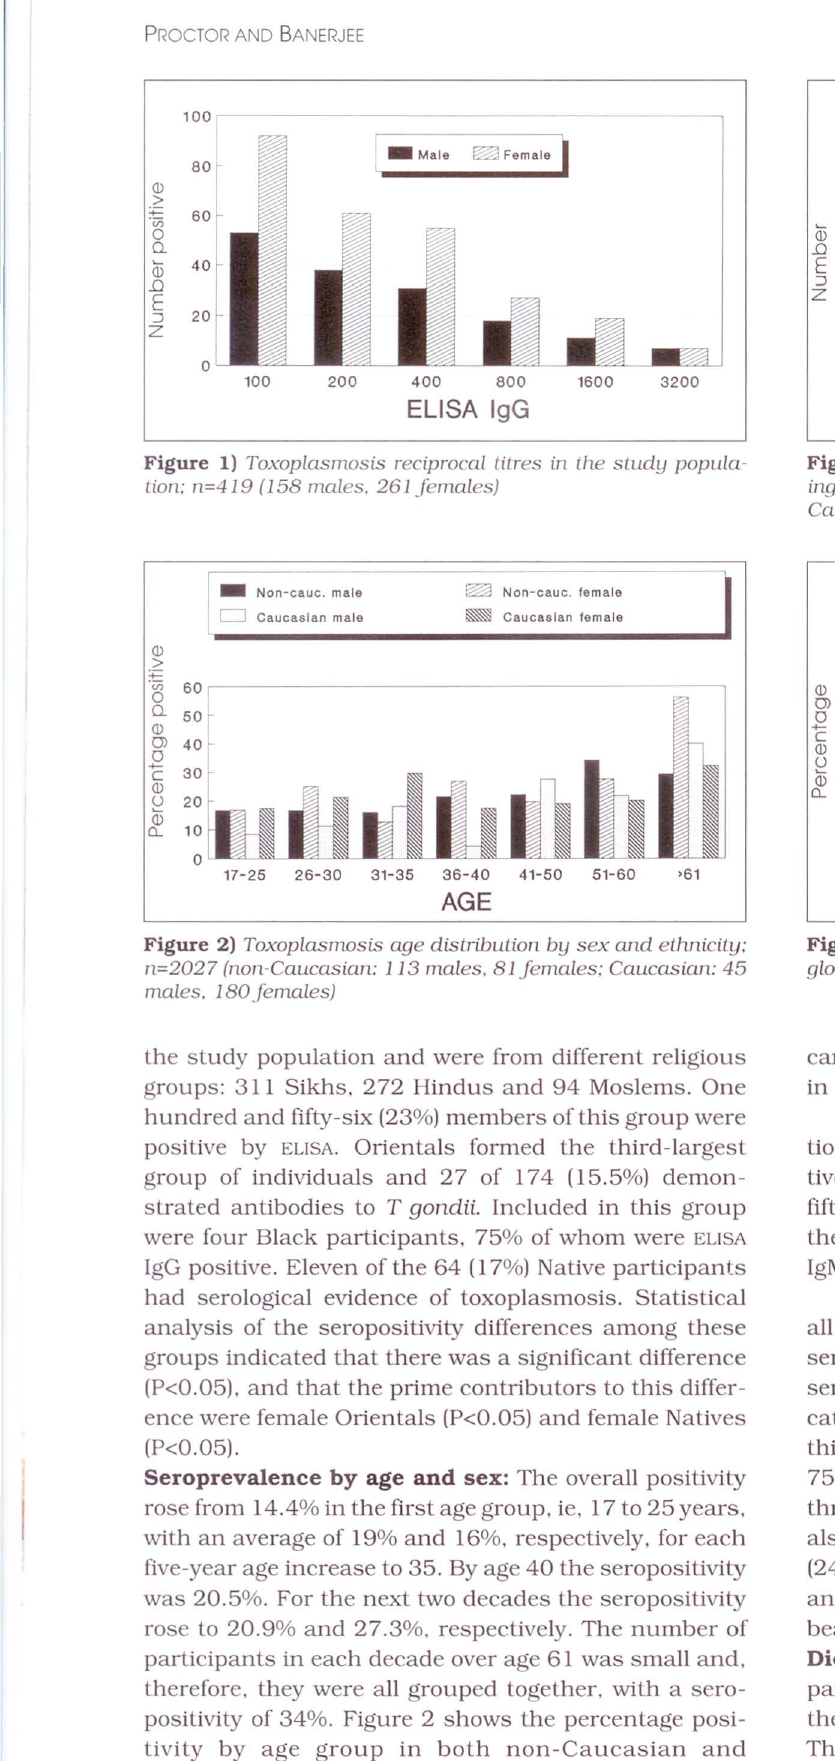
Figure 3) Toxoplasmosis female study participants of chi/bear ing age who were ELISA-negative: n=705 (non-Caucasian: 246: